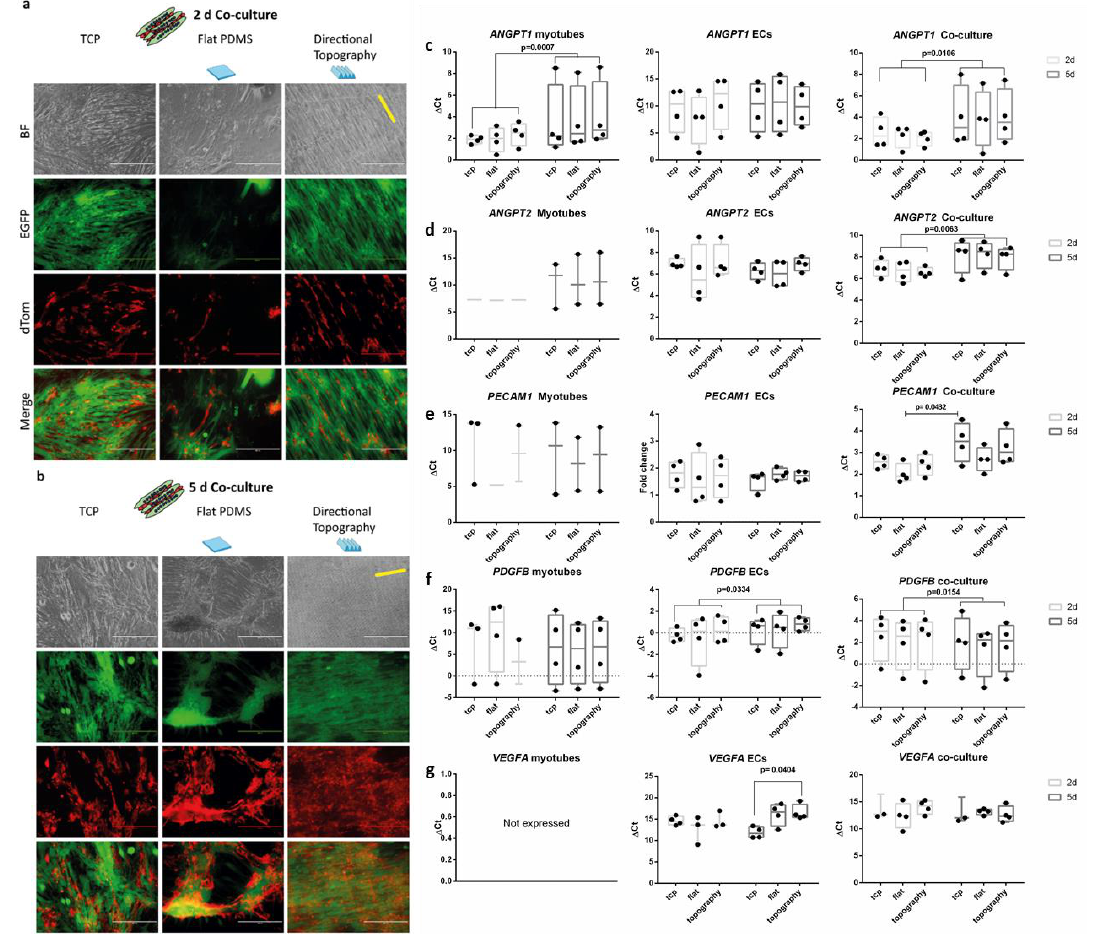
Figure 4. Life cell imaging of co-cultures. Endothelial cells (red, dTomato) aligned following the myotube (green, EGFP) directionality. Micrographs of co-cultures after two days ( a ) and five days ( b ) on, respectively, flat tissue culture polystyrene (TCPs), flat PDMS, and PDMS with directional topography (indicated with yellow line). Note that flat PDMS poorly supports adhesion and maintenance of either myotubes or endothelial cells. Scale bars are 400 µm. ( c – g ) qPCR of angiogenic growth factors.